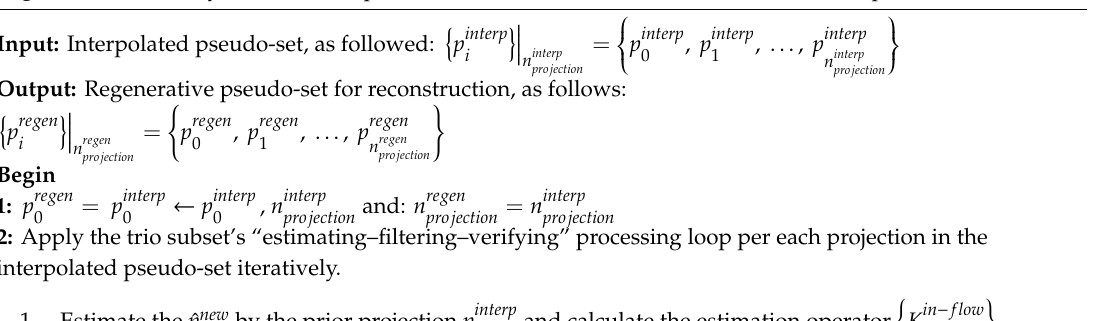
Algorithm 2: “Quality enhancement process” or Pseudo-Set Trio Subset Enhancement